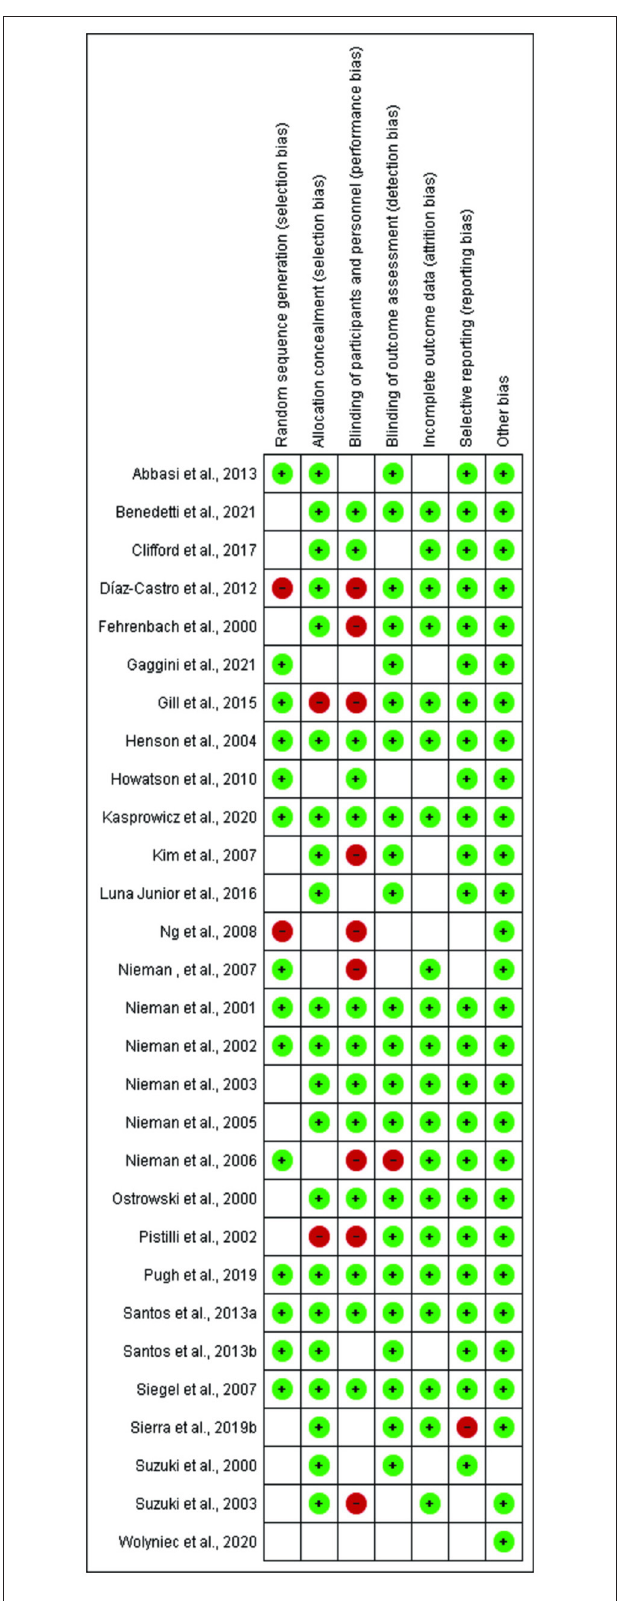
FIGURE 3 | Risk of bias